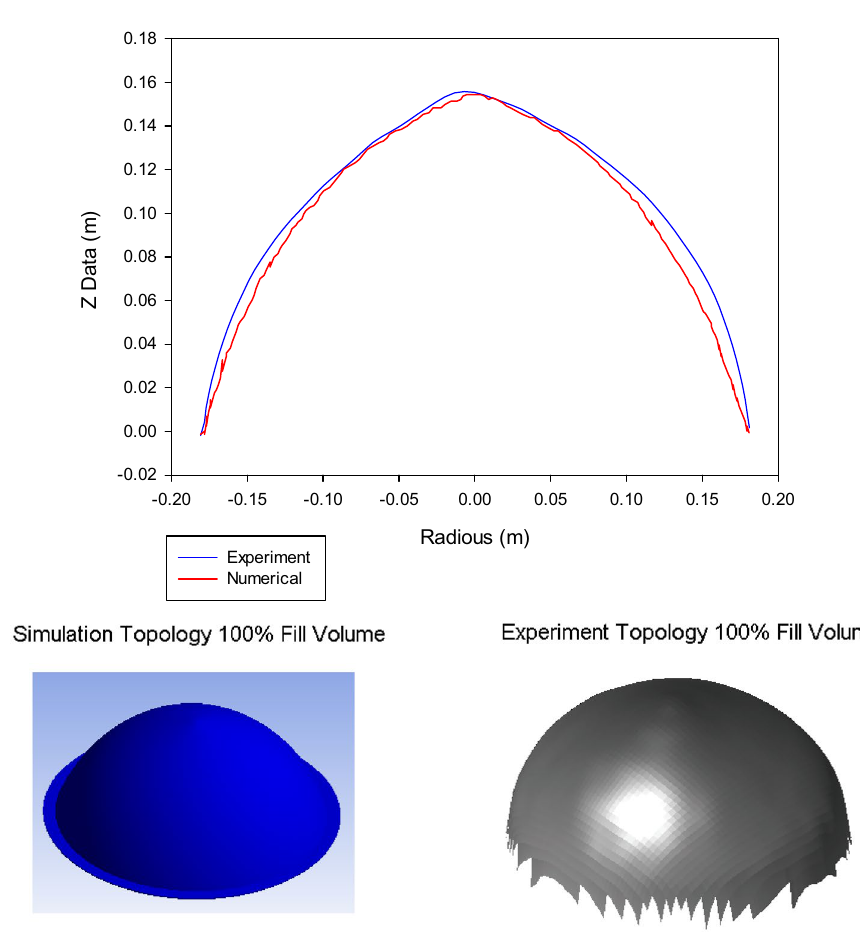
Cross section at 100% volume